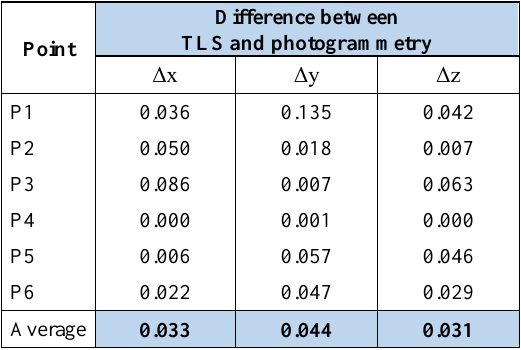
Table 2. 3D coordinates difference (absolute values) between TLS and Photogrammetric models, expressed in